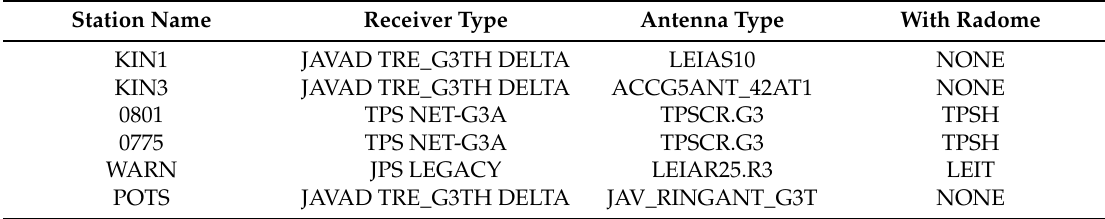
Table 1. Hardware equipment of the chosen stations from the Baltic Sea gravimetric